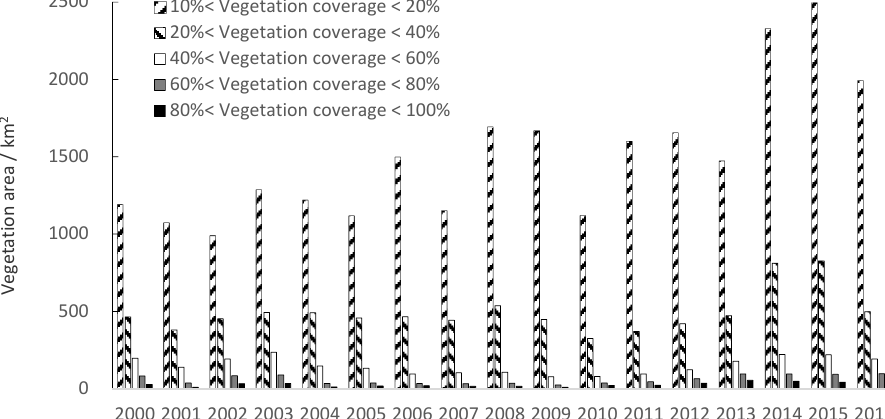
Figure 3. Vegetation area under different vegetation coverage gradients.